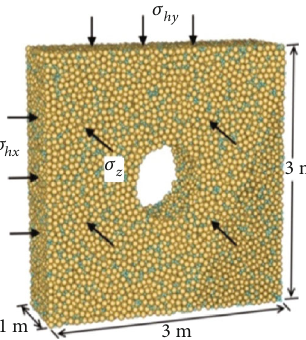
Figure 1: Discrete element model of borehole stability in hydrate